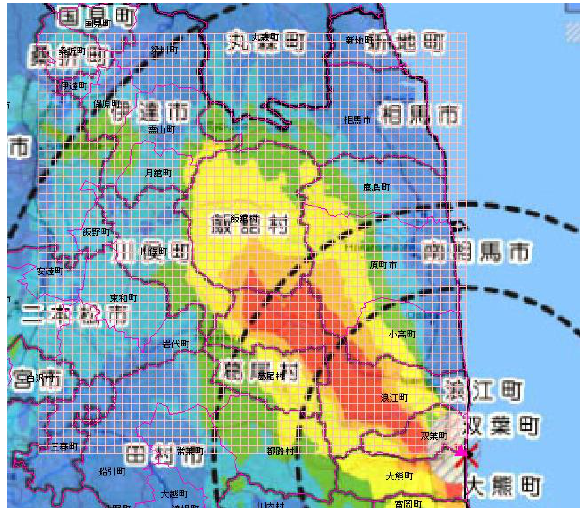
Figure 2. Aerial monitoring results and the objective area in